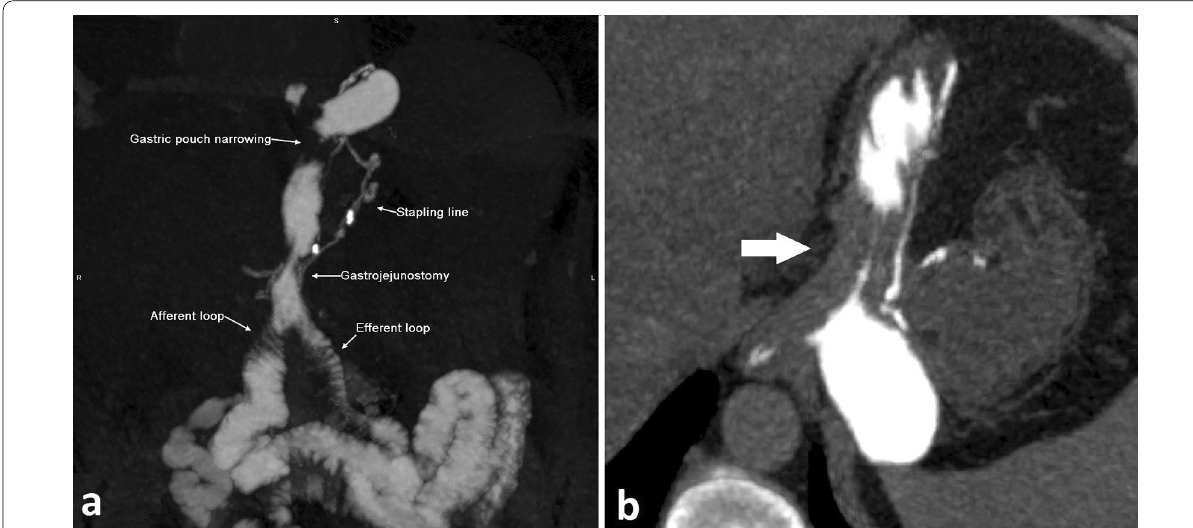
Fig. 7 Gastric pouch stricture complicating mini‑gastric bypass. Coronal MIP image ( a ) reveals the different post‑operative anatomical changes including intact radiodense stapling line, patent gastrojejunostomy site, patent both afferent and efferent jejunal loops with significant concentric narrowing at gastric pouch. Free passage of oral contrast is noted as well into jejunal loops distally. Axial CT image ( b ) clearly demonstrates the severe concentric stenosis at gastric pouch. Patient was complaining of persistent vomiting and endoscopic dilatation with planned thereafter based upon CT result